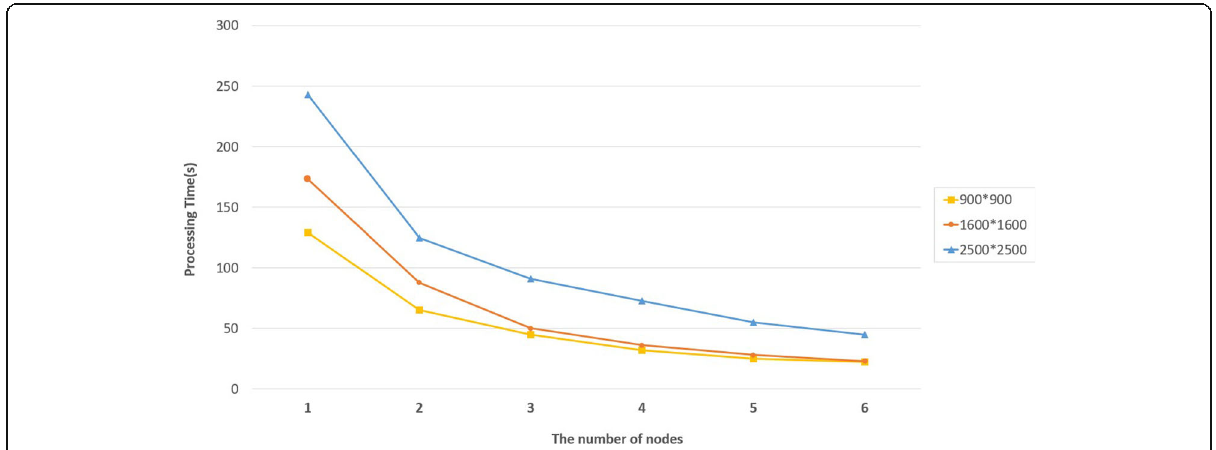
Fig. 11 Performance comparison of GPU resource with respect to the number of node on